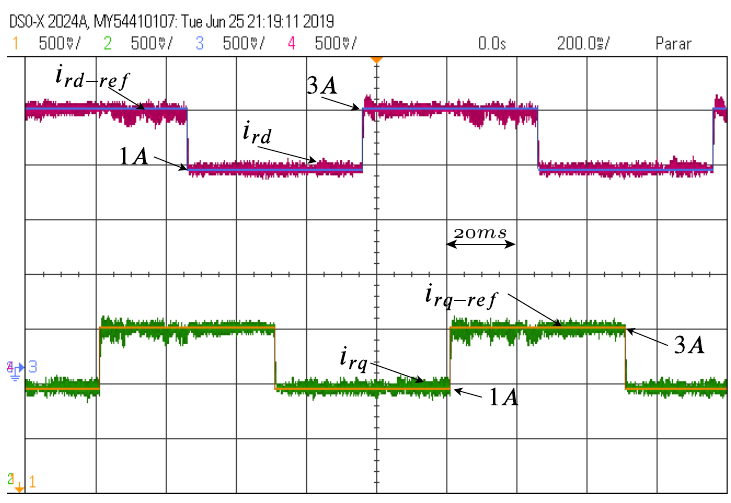
Figure 5. (cid:126) i rdq following their references in step test normal operation.